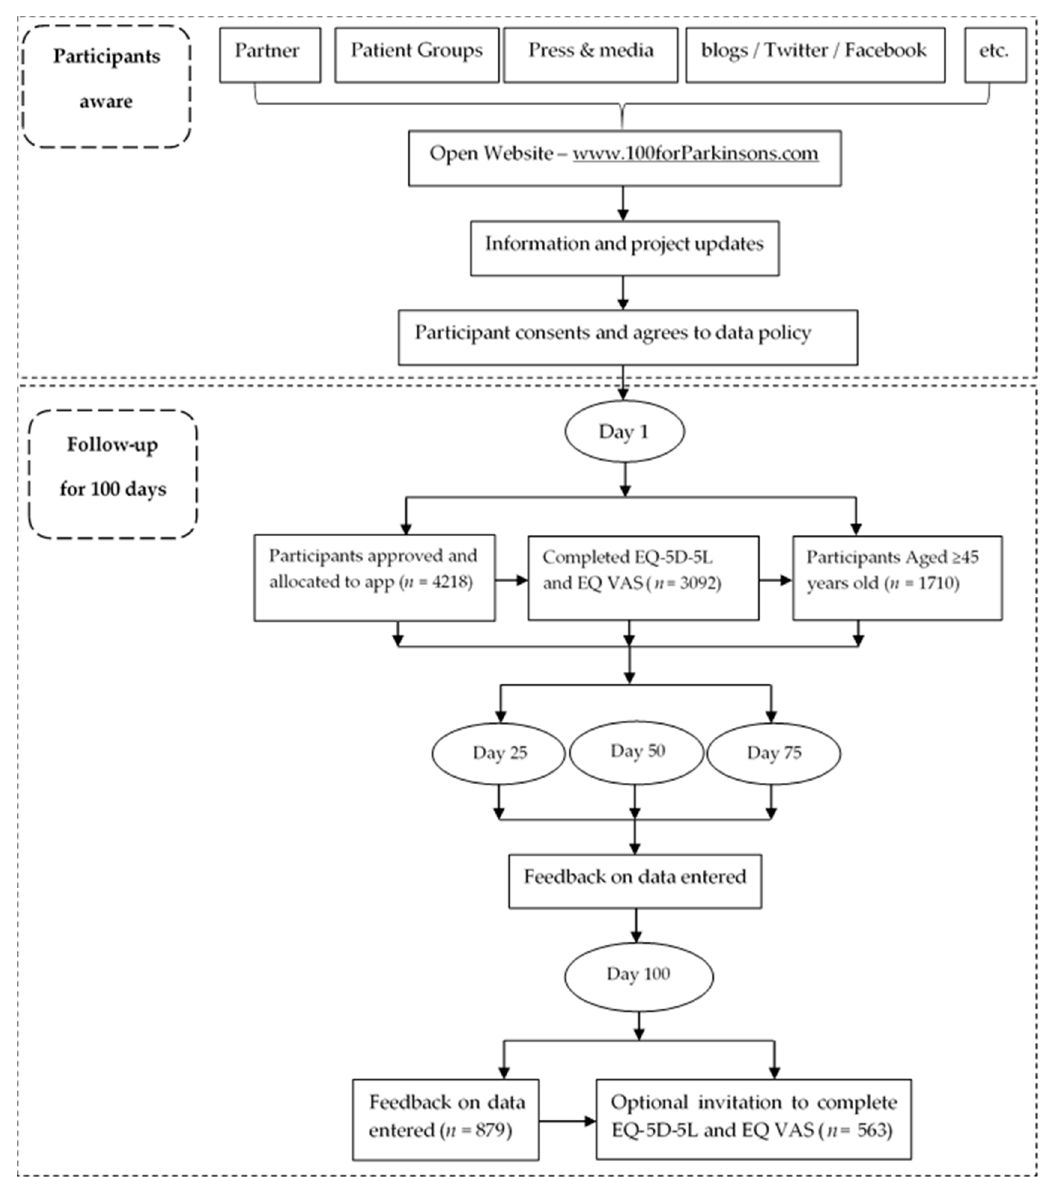
Figure 1. Participants flow chart of 100 for Parkinson’s project.